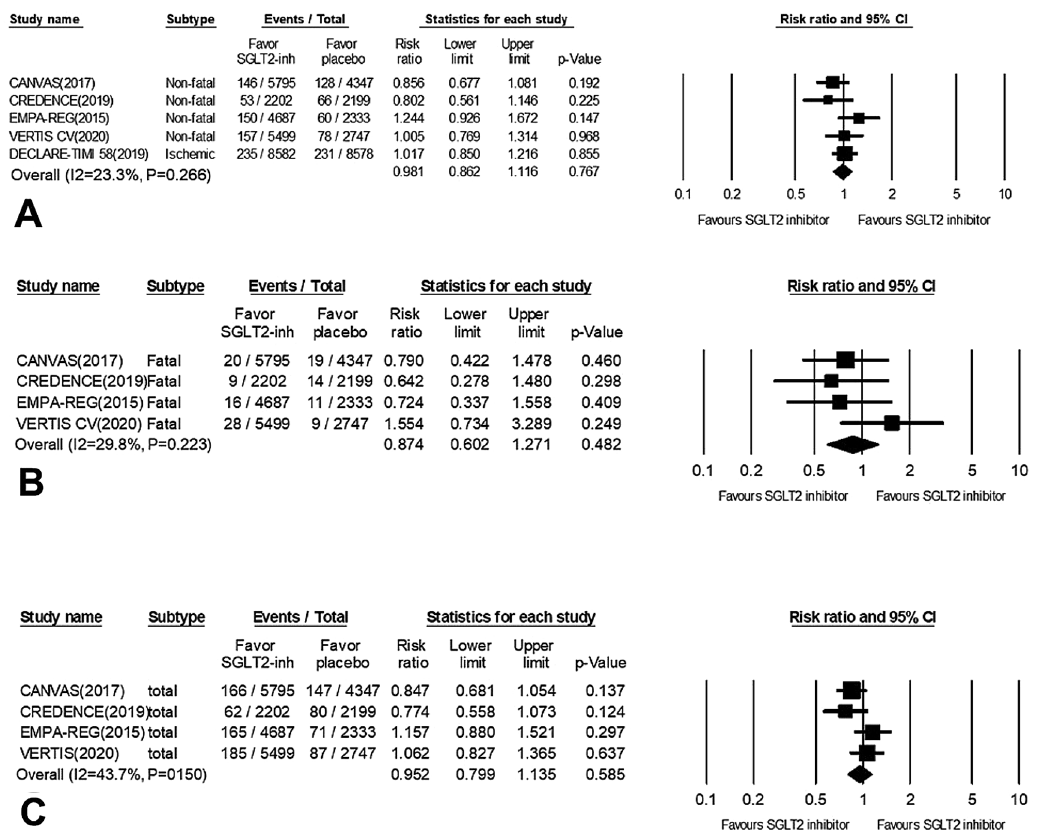
Figure 2. Forest plots for meta-analysis of the effects of SGLT2 inhibitors on stroke outcomes: ( A ) non-fatal stroke; ( B ) fatal stroke and ( C ) total stroke. Summary effects for all drugs were obtained from a random-effect